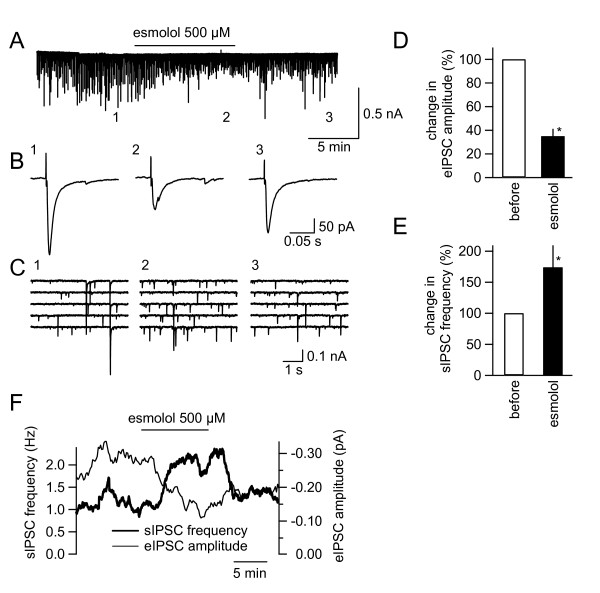
The increase in spontaneous inhibitory postsynaptic current (sIPSC) frequency by esmolol in neurons of the caudal part of the spinal trigeminal nucleus (Sp5c). (A) The membrane current recording of an Sp5c neuron. Esmolol was applied at the horizontal bar. (B) Traces showing evoked IPSC (eIPSC) waveforms (average of eight consecutive traces) evoked by stimulation before (1; left), during (2; middle) and after (3; right) esmolol application in the Sp5c. 1-3 were sampled at points 1-3 in A. (C) 1-3 are time-extended traces taken at points 1-3 in the trace in A. (D) and (E) Summary of the effects of esmolol on eIPSC amplitude and sIPSC frequency, respectively. *, P < 0.05; Mann-Whitney's U-test. (F) The time course of the changes with esmolol in sIPSC frequency (thick line) and eIPSC amplitude (thin line) that were simultaneously recorded. The abscissae of these graphs are identical (time).